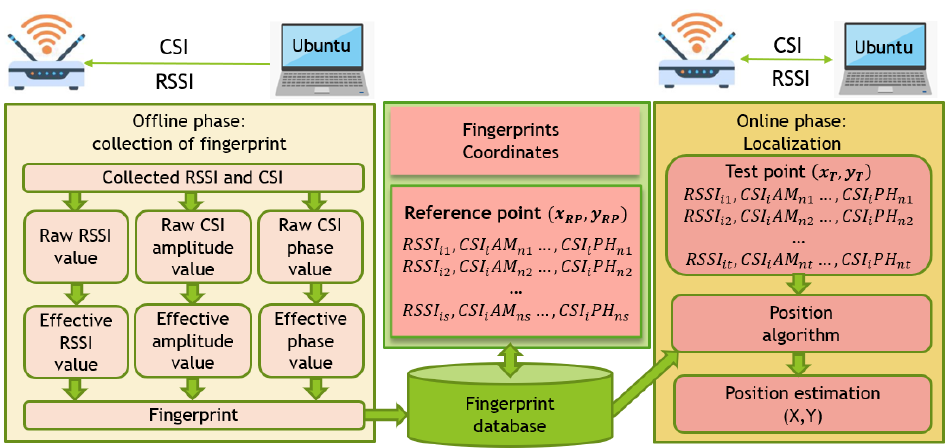
Figure 1. Indoor fingerprint localization